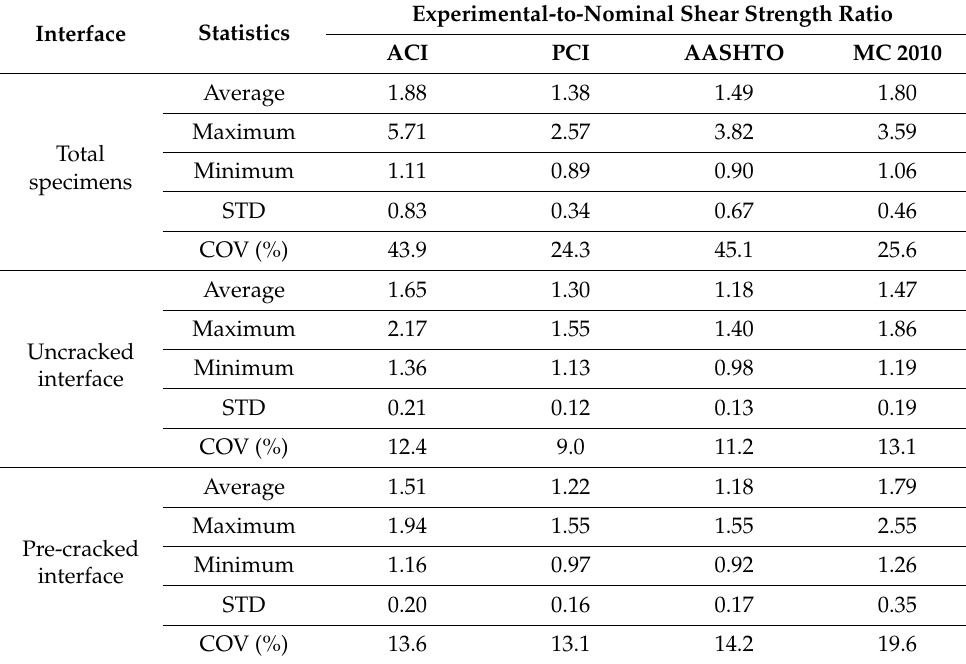
Table 5. Statistical analysis between design provisions and database of push-off